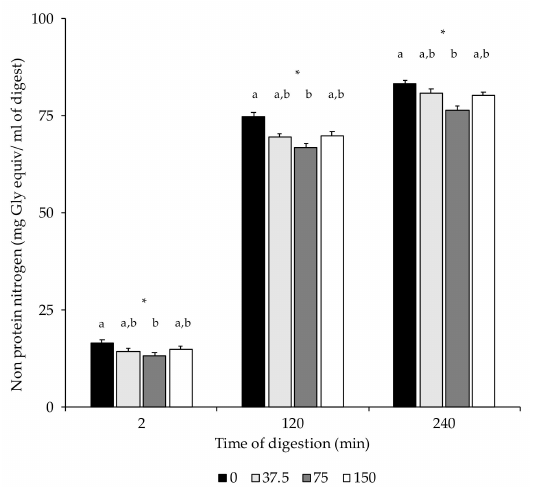
Figure 3. Non-protein nitrogen content (mg Gly equiv/mL of digest) in digest at the end of the oral (2 min), gastric (120 min), and intestinal phase (240 min). *: p < 0.05. a,b: Values for the same time of sampling bearing different letters are significantly different at p ≤ 0.05, Tukey’s test.